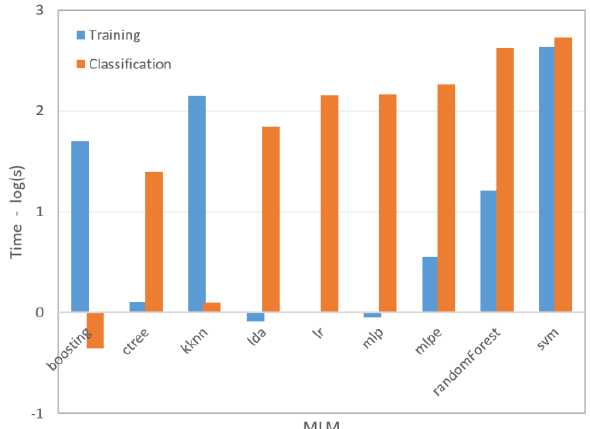
Figure 5. Processing speed of different MLMs for training and classification using the highest number of pixels for training (6x10 4